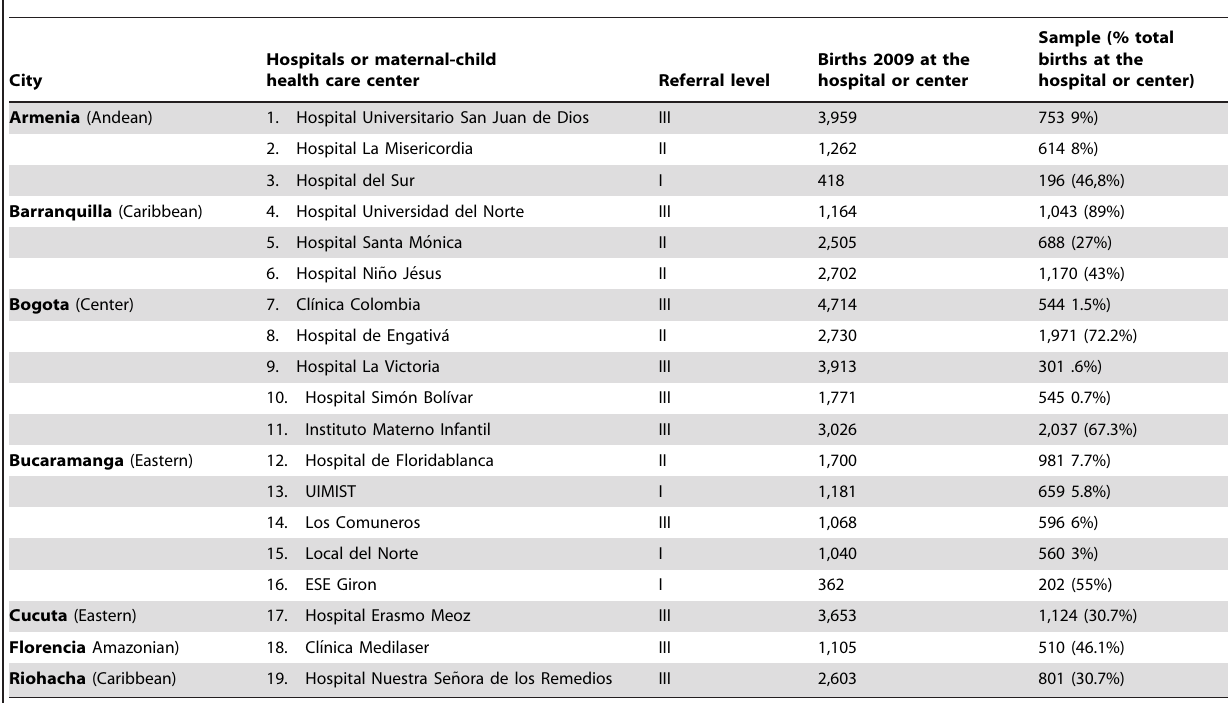
Table 1. Births and sample for newborn screening and referral level of participating